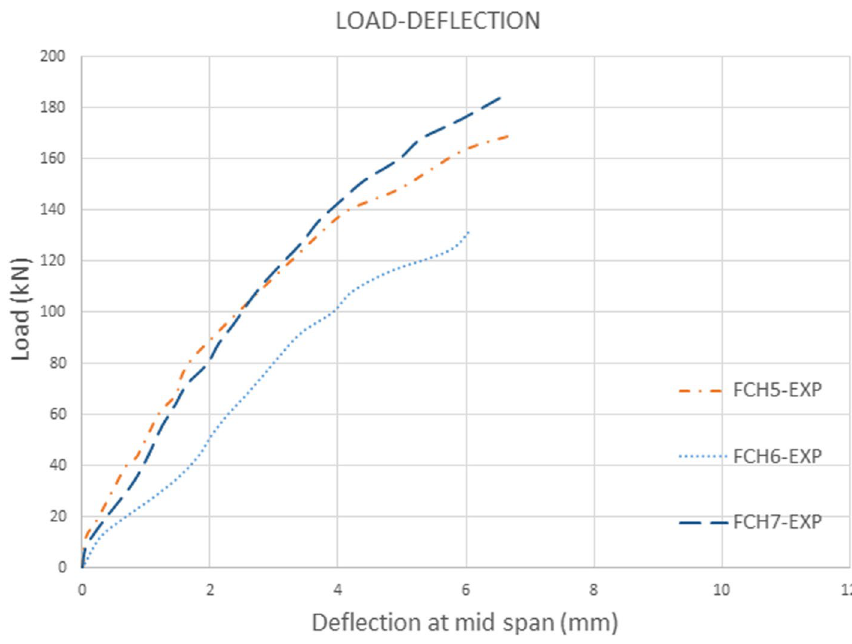
Fig. 20 Load vs. mid-span deflection curves for FCH5, FCH6, and FCH7